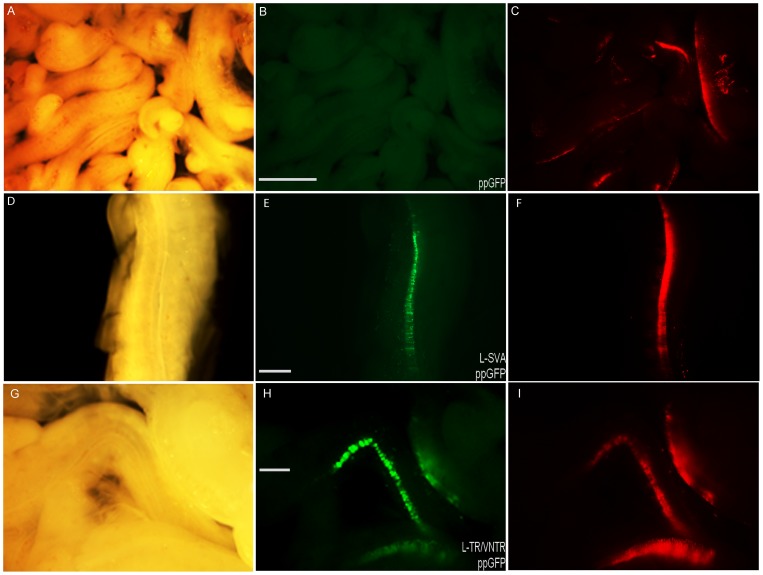
Demonstration of the activity of the L-SVA and L-VNTR presumptive transcriptional regulator in the chick embryo model at stage 22 HH.Chick embryos were electroporated with either a FUS proximal promoter GFP (ppGFP) reporter construct (A–C), L-SVA ppGFP-reporter (D–F) or L-TR/VNTR ppGFP-reporter (G–I) at stage 14HH and GFP expression analysed 48 hr later (stage 22HH). Expression could not be detected in the neural tube from the FUS proximal promoter sequences alone (B), however when either the L-SVA (E) or L-TR/VNTR (H) sequences were included, GFP reporter gene expression could readily be seen. Panels A, D and G show the corresponding bright field images. Panels C, F and I show the identical fields taken with a red filter to demonstrate the extent of successful electroporation of the neural tube using a control tomato marker expression plasmid. Scale bar in B is 2 mm and in E & H is 1 mm.